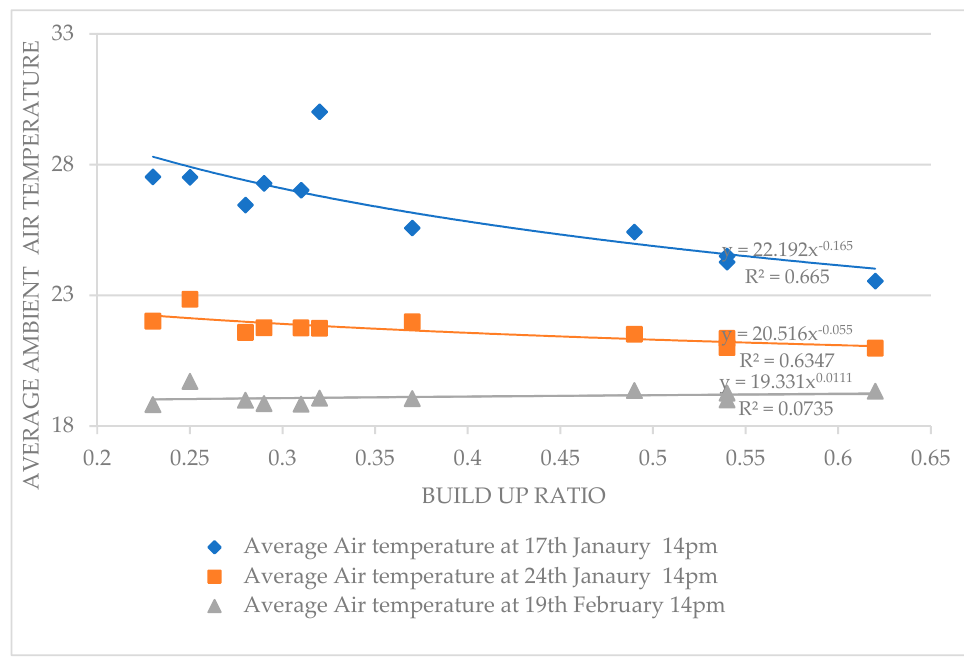
Table 17. Average Air temperature on 17th (A), 24th January (B), and 19th February (C) at 2 pm and built-up ratio in all configurations.